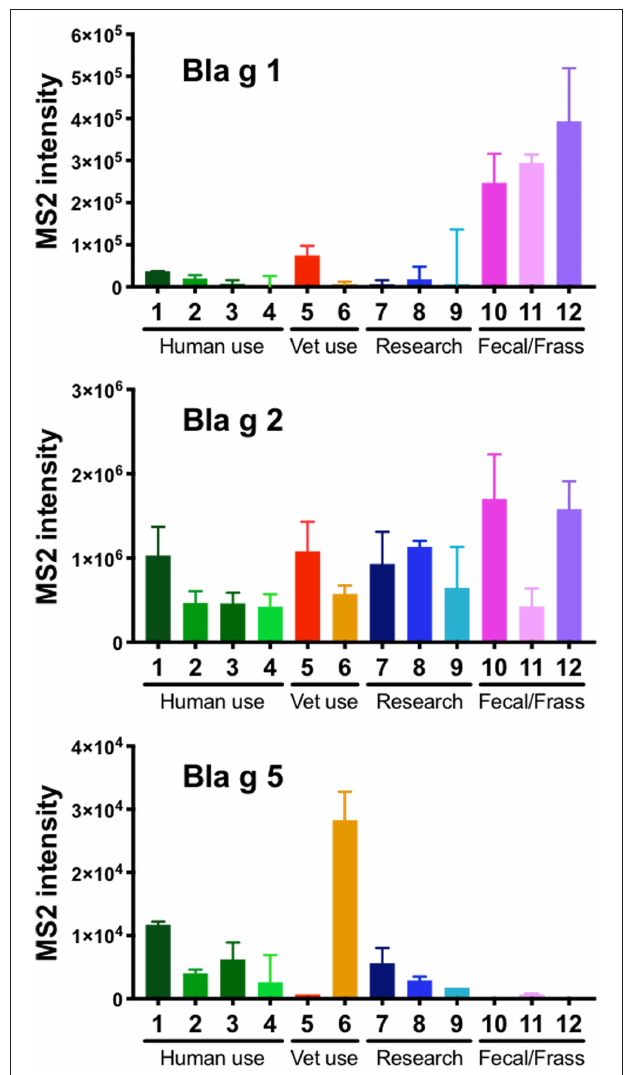
FIGURE 1 | Quantification of Bla g 1, 2, and 5 in 12 different German cockroach extracts by mass spectrometry (MS). Bar graphs showing the content of peptides derived from Bla g 1, 2, and 5 as detected by MS in 12 different extracts, including extracts for human use, veterinary use, research use and extracts made from German cockroach fecal matter/frass. Bars indicate median values of triplicate readings and error bars indicate 95% confidence interval. Of note, all 3 graphs have a different